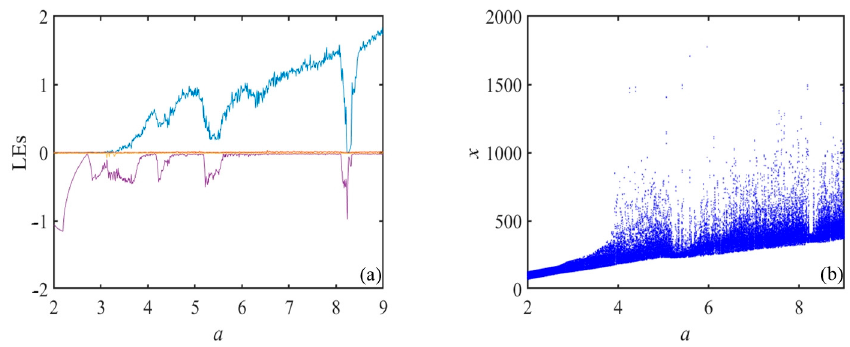
Table 1. The system exhibits strong sensitivity, as can be seen from a ∈ [8.26, 8.30], where